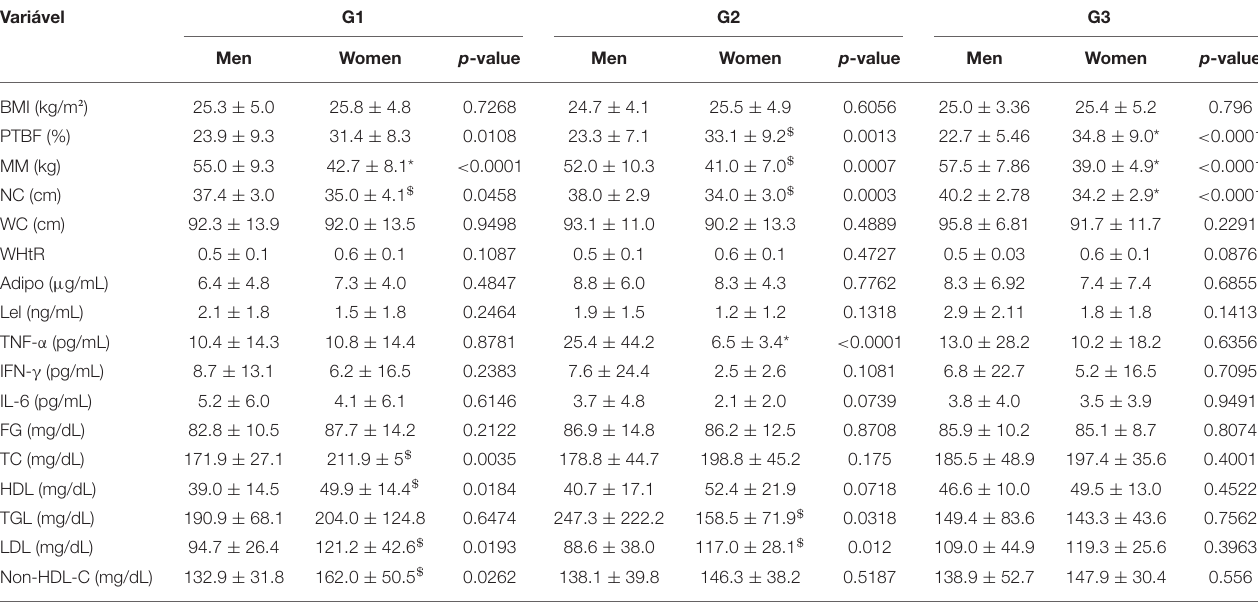
TABLE 8 | Comparison between men and women intragroup of people living with HIV/AIDS with (G1) and without HALS (G2) and control group (G3), for anthropometric, body composition, and adipocytokine and cytokine parameters. Variável G1 G2 G3 Men Women p -value Men Women p -value Men Women p -value